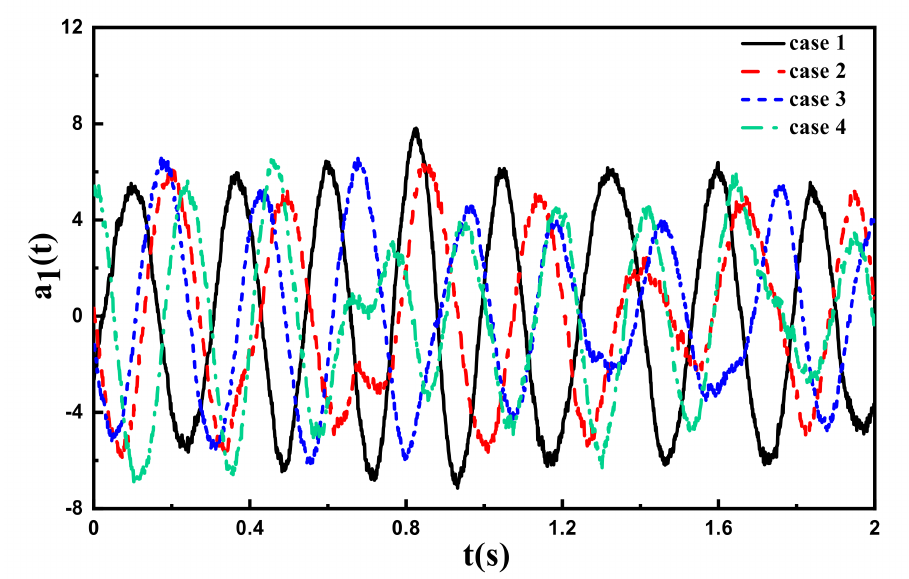
Figure 12. The distribution of POD mode coefficient with the temporal variation for the smooth cylinder and the dimpled cylinder with different numbers.